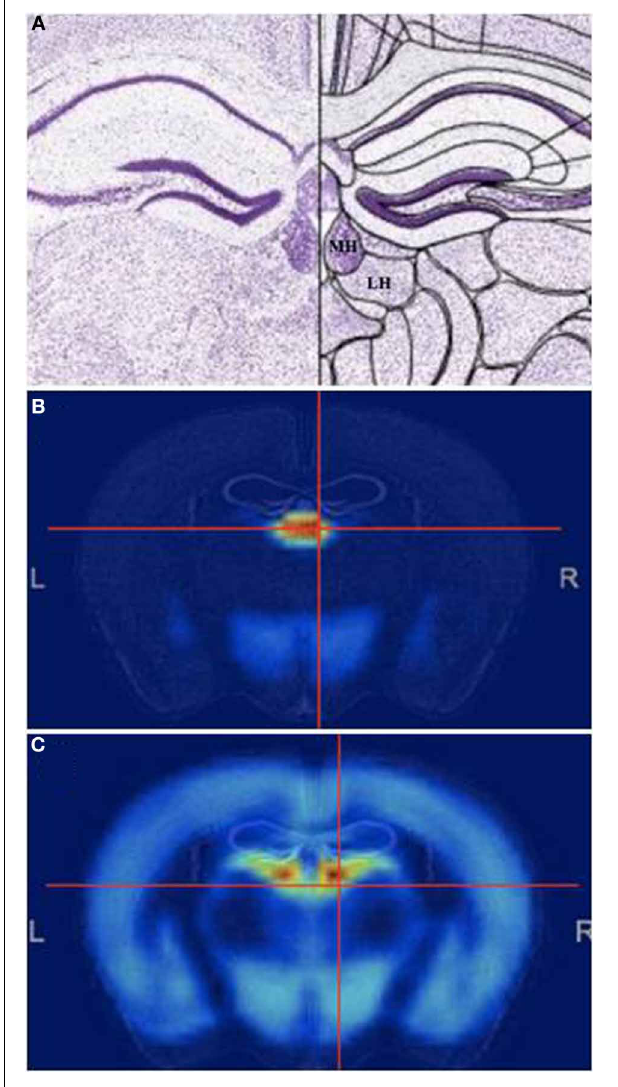
FIGURE 1 | The Medial habenula. (A) Mouse coronal brain section at the level of the medial habenula, stained with Nissl. Medial (MHb) and lateral (LHb) are indicated. (B,C) Pattern of general genetic co-expression in the mouse brain using the MHb (B) or the LHb (C) as seeds. Note that the expression patterns are completely different. All figures from the Allen Brain Atlas (Lein et al.,